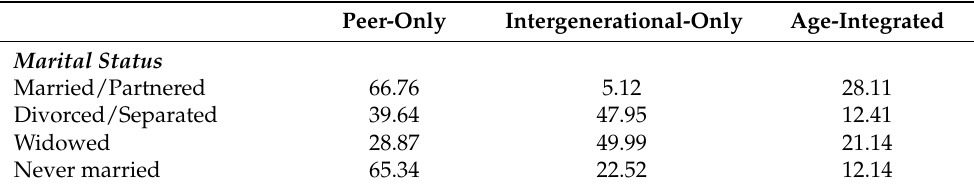
Table A1. Row Percentages, Age Integration Status and Confounding